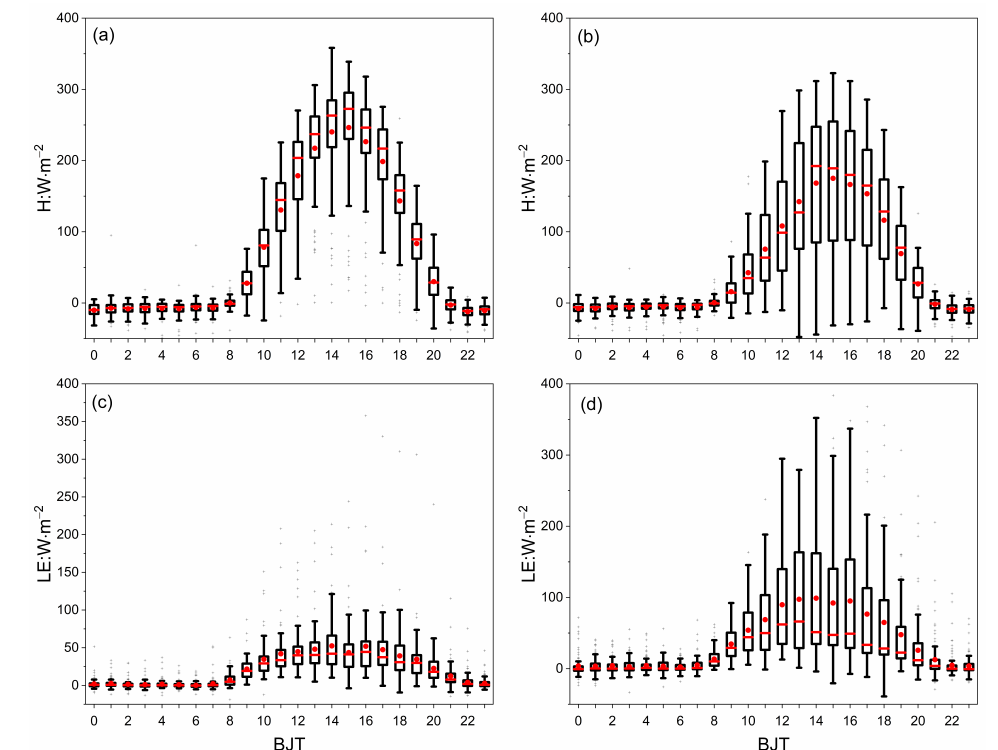
Figure 1. Cont . Figure 8. Diurnal variation of sensible heat flux (H:W · m − 2 ) in the PV plant ( a ) and the reference site ( b ) and the latent heat flux (LE:W · m − 2 ) in the PV plant ( c ) and the reference site ( d ). The height of the box shows the range from the 25th to 75th percentile. The horizontal red line inside the box and solid red dot denote the median value and mean value, respectively. The ends of the whiskers were drawn to the 10th and 90th percentile